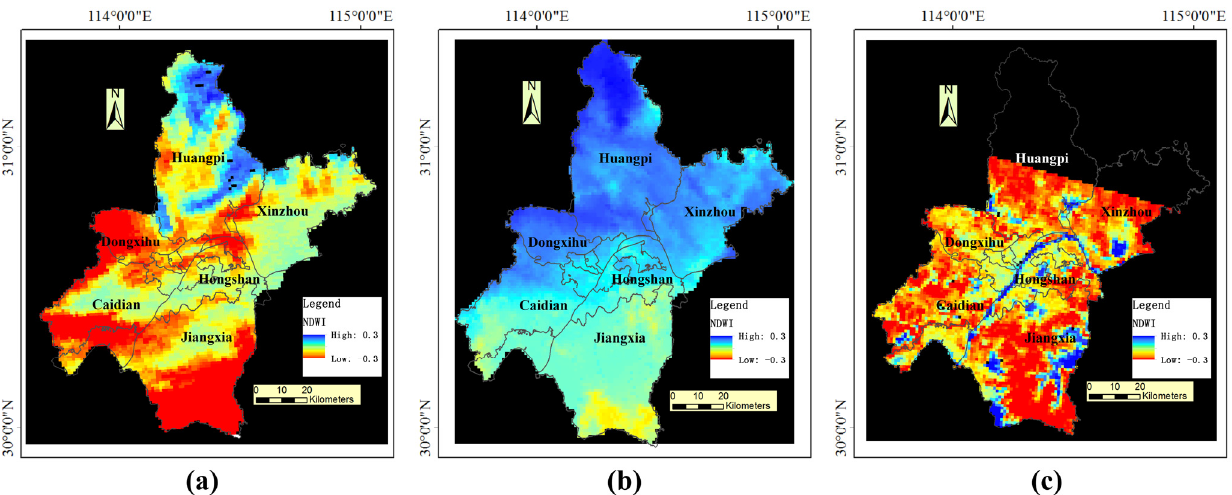
Figure 6. AVHRR waterlog NDWI distributions in Wuhan city during periods of torrential rainfall: 27 March 2015 ( a ), 1 April 2015 ( b ) and 8 April 2015 ( c